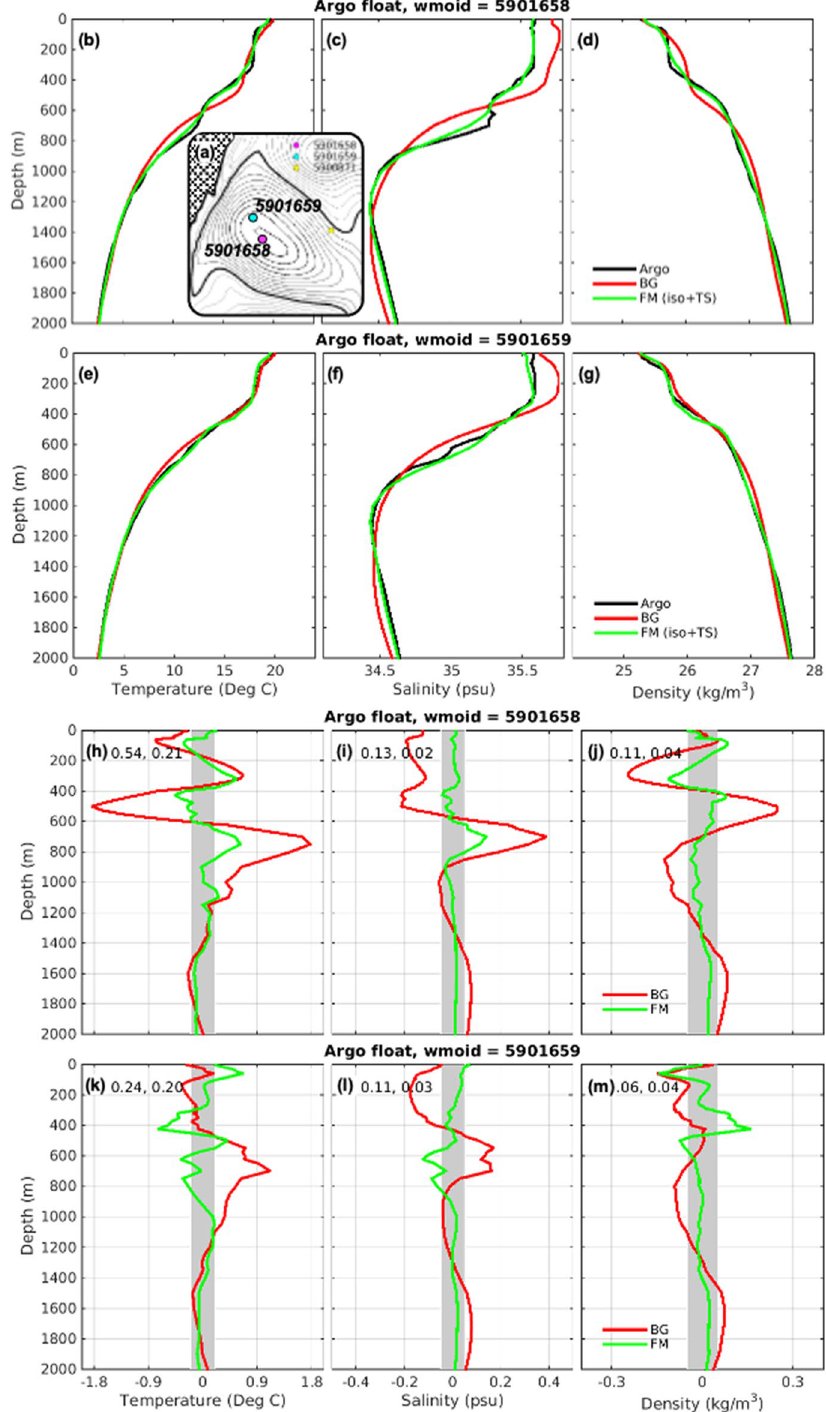
Figure 5. A demonstration of feature mapping, using independent Argo profiles for validation. Profiles of ( b–g ) observed (black), background (red) and feature-mapped (green) temperature, salinity, and potential density; and ( h–m ) mis-fits between observed profiles and background (red) and feature-mapped (green) profiles; within an eddy off south-eastern Australia. The RMSD between the observed and BG and observed and FM profiles are reported in panels ( h–m ). The grey bands denote the target mis-fits, based on the Argo buddy analysis. Here, two Argo floats sample the same anticyclonic eddy—their locations are denoted in panel ( a ), overlaying a map of gridded SLA (black contours are positive; grey contours are negative; bold contour is zero; hatched is land). Profiles from float 5901658 are used to adjust the eddy properties, and profiles from float 5901659 are used here as independent